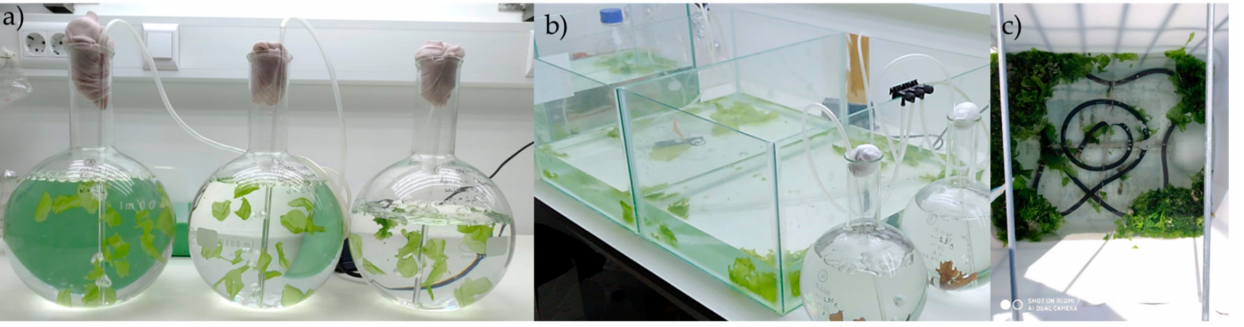
Figure 4. Seaweed cultivation techniques: ( a ) Volumetric flasks with Ulva sp. specimens in closed con- trolled cultivation; ( b ) aquaria with Ulva sp. specimens in closed controlled cultivation; ( c ) prototype cultivation tank (1000 L) with Ulva sp. from Lusalgae